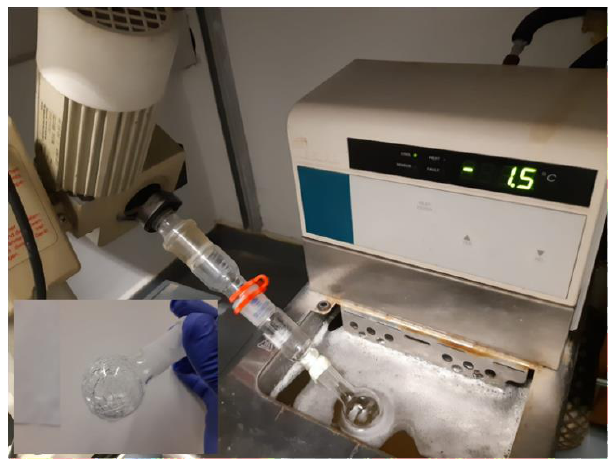
Figure 2. Ice-shell purification using a 10 mL round bottom flask.